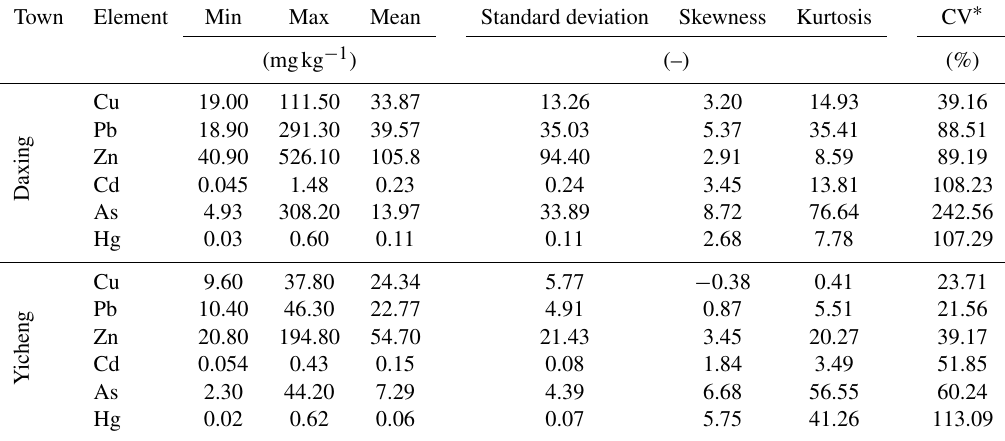
Table 1. Summary statistics of soil heavy metal concentrations within samples from the Daxing and Yicheng areas.